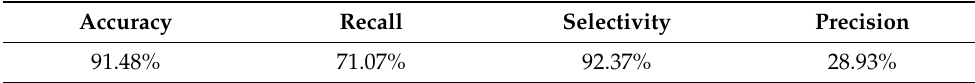
Table 5. Network parameters computed for the experimental data (sample S1).